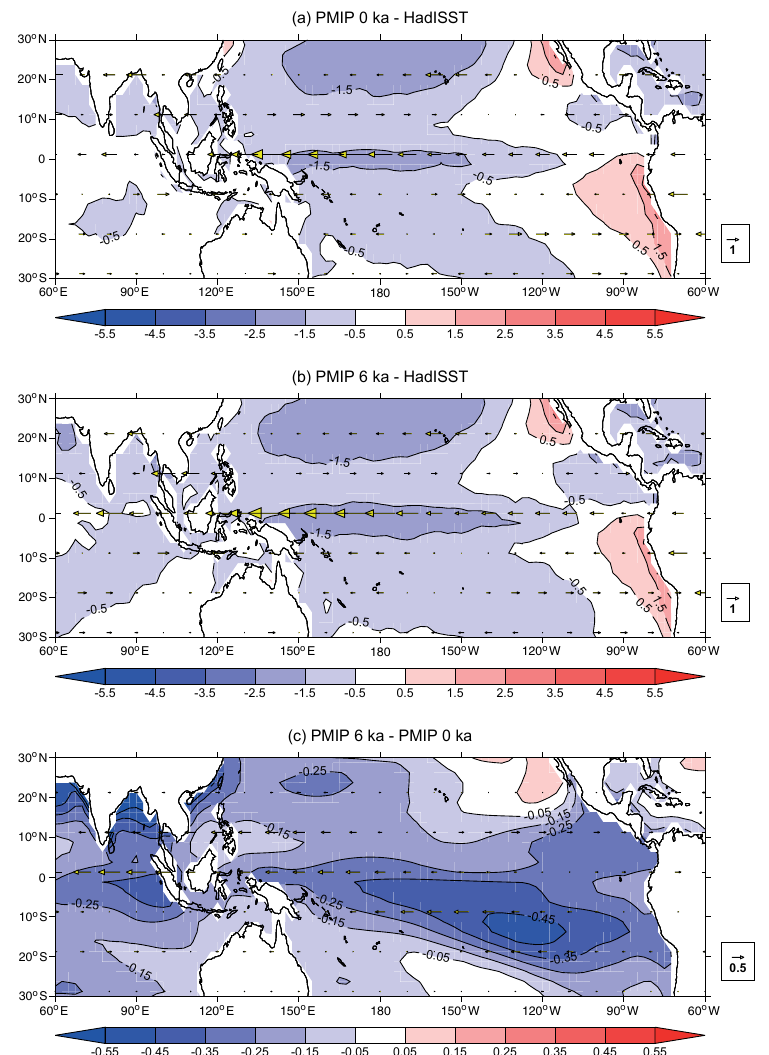
Figure 4. The multi-model mean difference in SST (shading, K) and 850hPa flow (arrows, ms − 1 ) for the 0ka simulations relative to HadISST (1870–1899 average) and ERA-Interim (1979–2008 average), respectively. (b) The same as (a) except for the 6ka simulations. (c) The multi-model mean difference in SST and 850hPa flow for the 6ka simulations relative to the 0ka simulations.